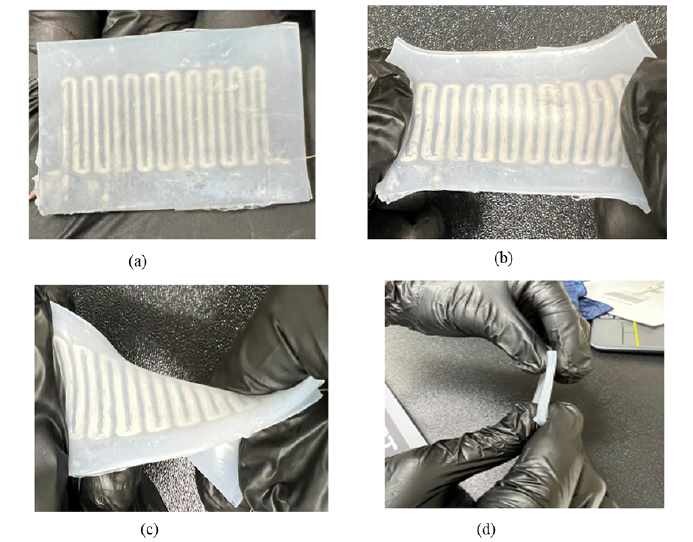
Figure 6. ( a ) The physical diagram of the preparation process of the liquid metal soft sensor. ( b ) Schematic diagram of the preparation process (stretching condition). ( c ) Schematic diagram after fabrication (bending condition). ( d ) Image of the fabricated stretchable sensor